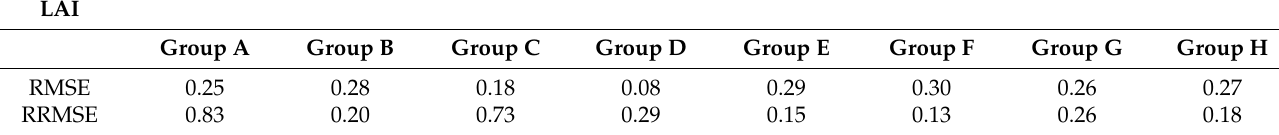
Table 8. Root Square Mean Error (RMSE) and Relative RMSE (RRMSE) calculated for each group of fields (as defined in Section 2.3.1) comparing the Leaf Area Index (LAI) calculated from Sentinel-2 data and LAI simulated by EnKF-SAFY_swb. LAI Group